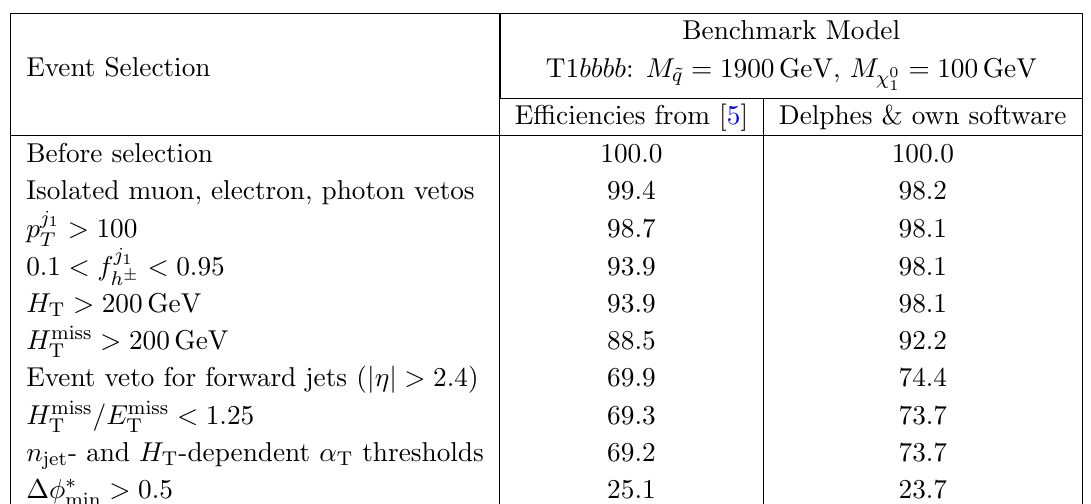
Figure 4. Feynman diagram showing gluino pair production and decay in the T 1 bbbb bench- mark model.